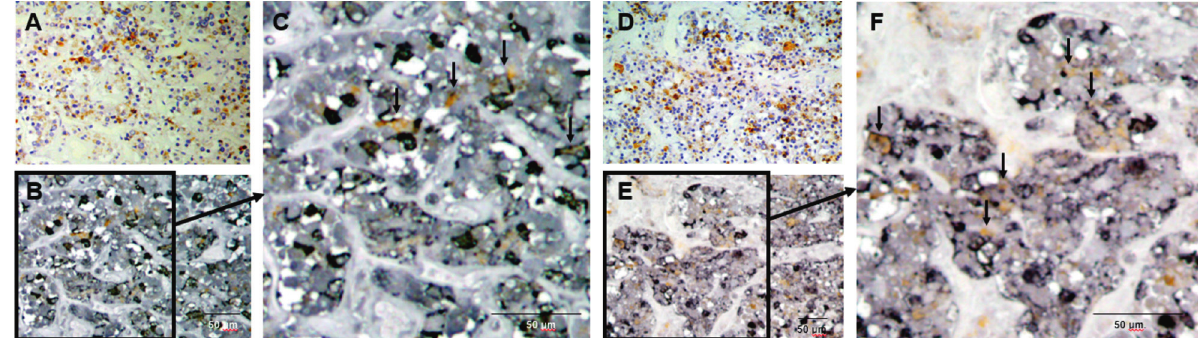
Figure 4: Double staining of (pro)renin receptor and luteinizing hormone or follicle-stimulating hormone. (A), (D) (Pro)renin receptor staining counterstained with hematoxylin; (B) double staining of (pro)renin receptor and luteinizing hormone in the identical section as (A); (C) high-power field of (B); (E) double staining of (pro)renin receptor and follicle-stimulating hormone in the identical section as (D); and (F) high-power field of (E). Arrows indicate cells costained with (pro)renin receptor.